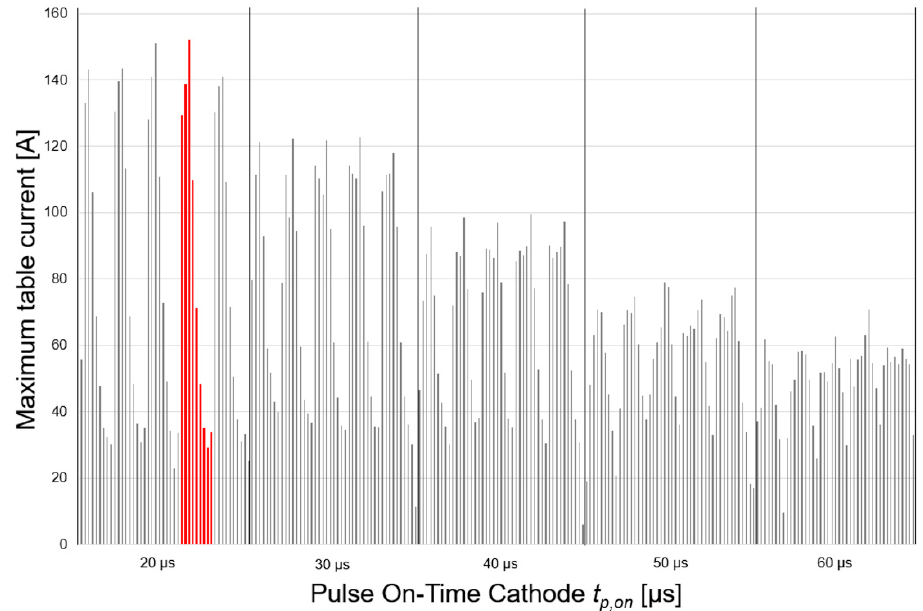
Figure 2. Results of all 500 Hz measurements with different pulse on-time values of the cathode with a 150Ar0Kr gas mix. The red highlighted measurements are the results of the bias offset range 0–80 µs with 150Ar0Kr at 500 Hz, a 20 µs cathode on-time and a bias on-time of 50 µs, which is also shown in Figure 3.